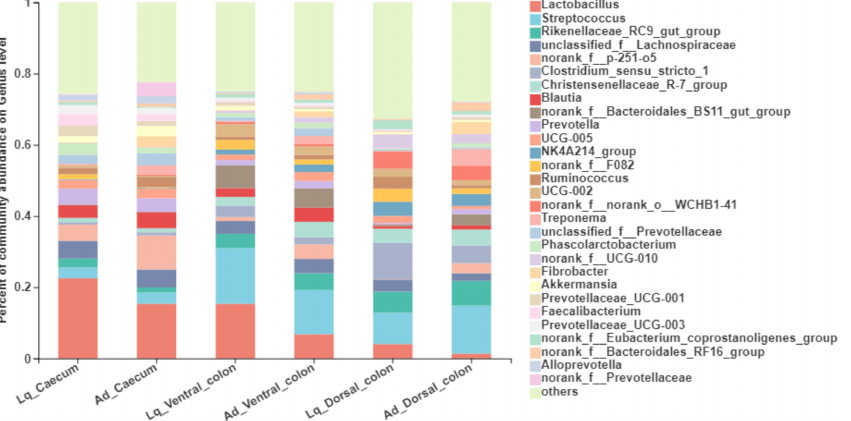
Figure 3. The bacterial community composition at the genus level in the liquid phase (Lq) and adherent fraction (Ad) within the donkey caeco-colic